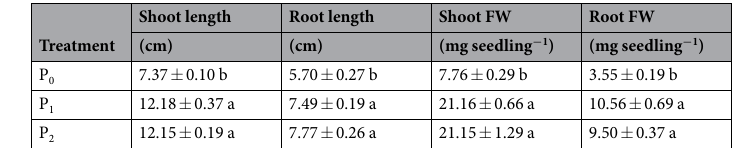
Table 5. The effect of two seed pelleting treatments on seedling growth parameters of direct-seeded rice under waterlogging conditions at 9 DAS in Field Experiment. Within a column under each water condition, means followed by different letters are significantly different at a 0.05 probability level according to a least significant difference (LSD) test.